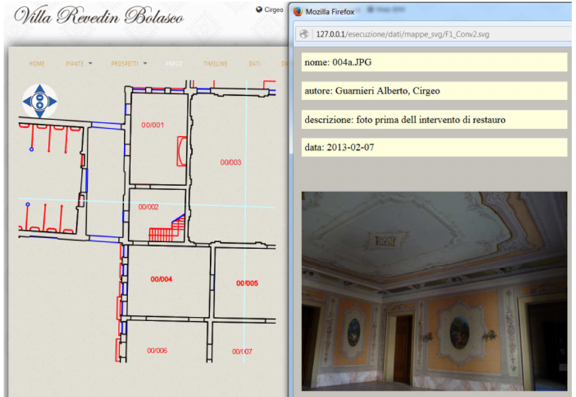
Figure 9. Floorplans navigation and query.